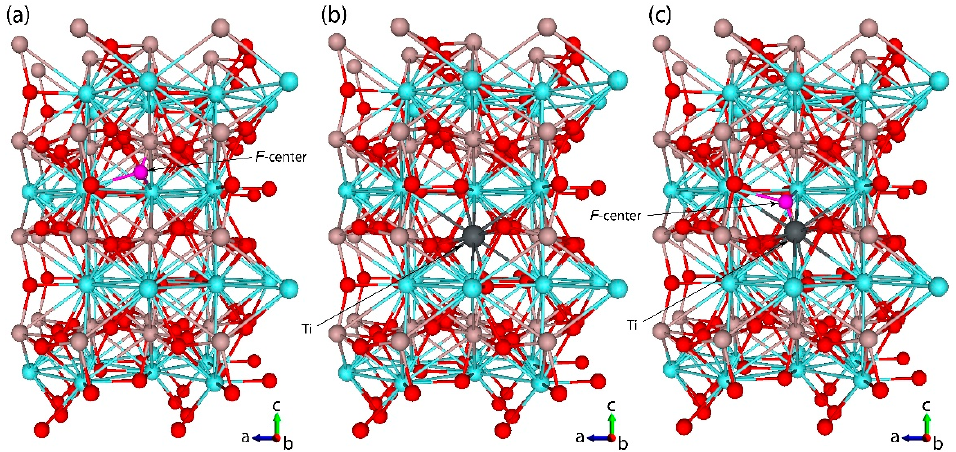
Figure 1. Equilibrium structure of 2 × 2 × 2 supercell of orthorhombic Pbnm YAlO 3 with ( a ) F-center, ( b ) Ti 3+ ion and ( c ) Ti 2+ ion substituted for host Al 3+ atom. The supercell contains 160 atoms in a periodically repeated unit. The Ti dopant is shown as a dark-grey ball, the compensating F -center is a small pink ball, and the Y, Al, and O sublattices are shown in light blue, brown, and red, respectively. The “b” crystallographic axis is perpendicular to the figure plane and is directed outward.